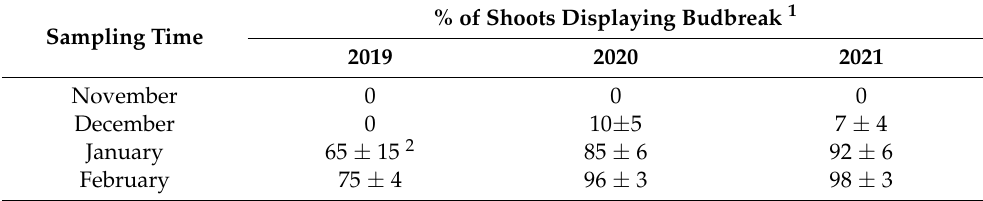
Table 1. Results of the destructive tests of the release of endodormancy conducted in parallel with non-invasive